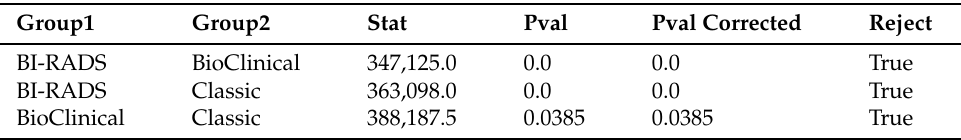
Table A6. Bonferonni-corrected Mann–Whitney U test results for section segmentation without auxiliary